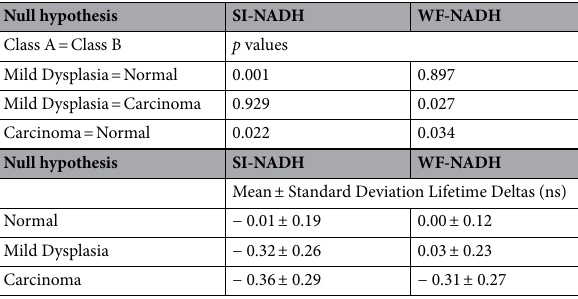
Table 1. Summary of statistics for the SI-NADH and WF-NADH lifetime channels. P values are shown where significance indicates a rejection of the null hypothesis stated in the left column. Mean lifetime values and standard deviation are displayed based on the verification of approximate normality.